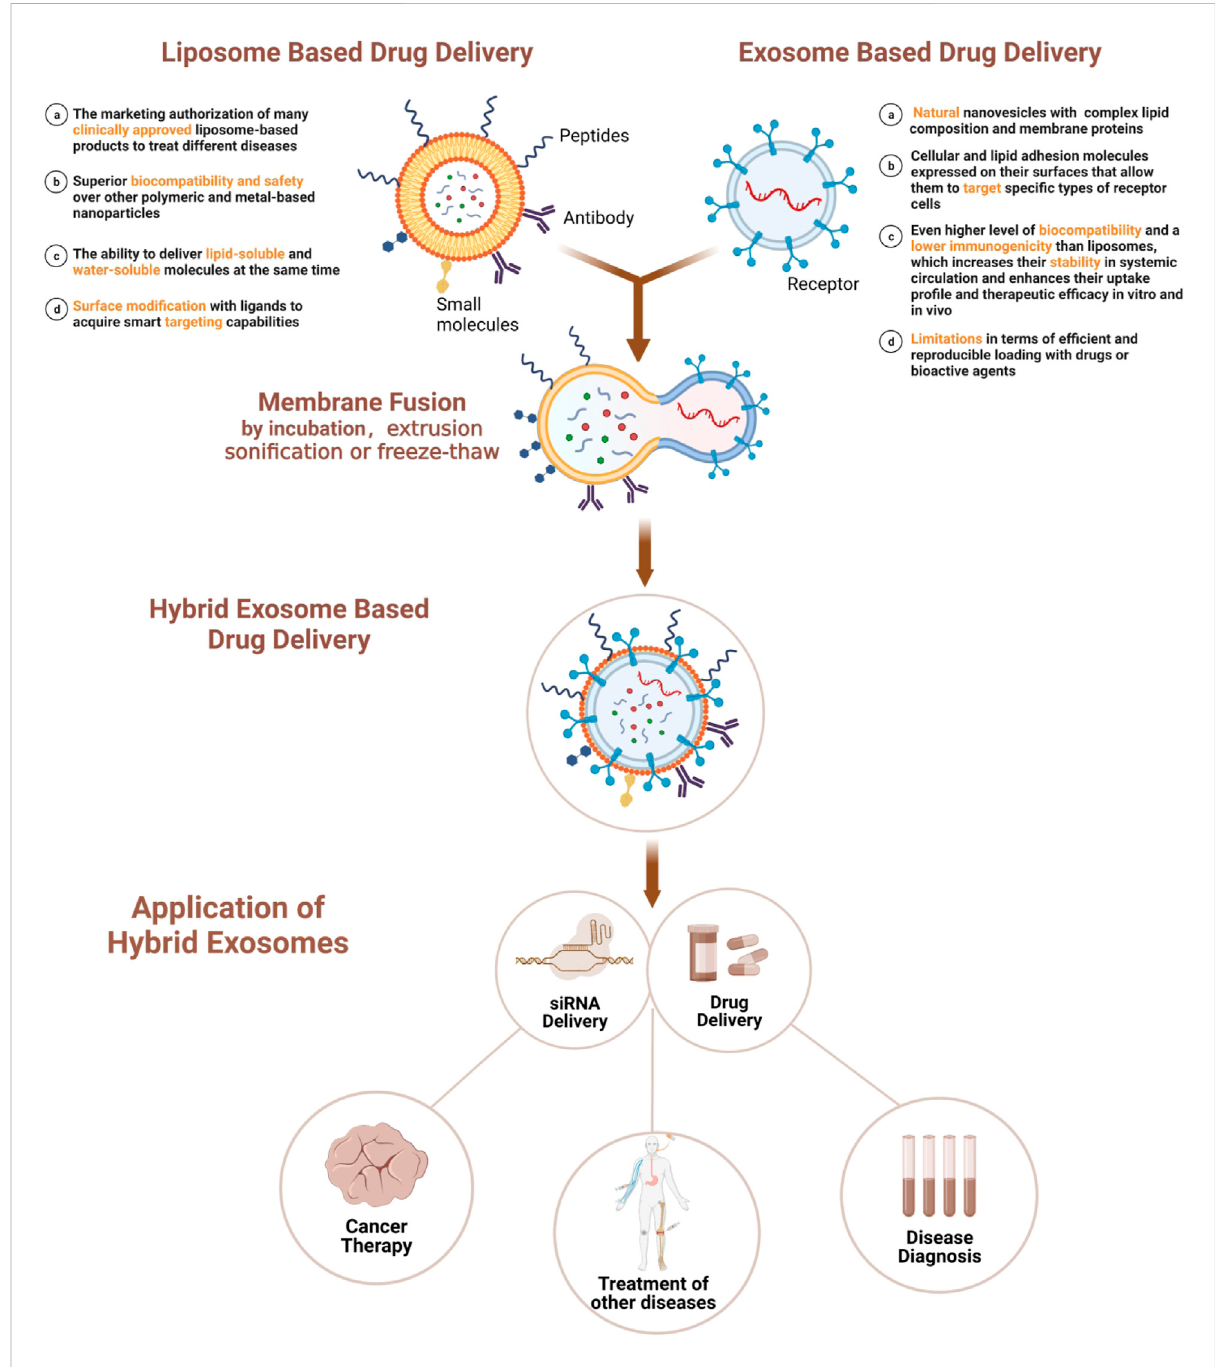
FIGURE 1 Membrane fusion-based hybrid exosome preparation and